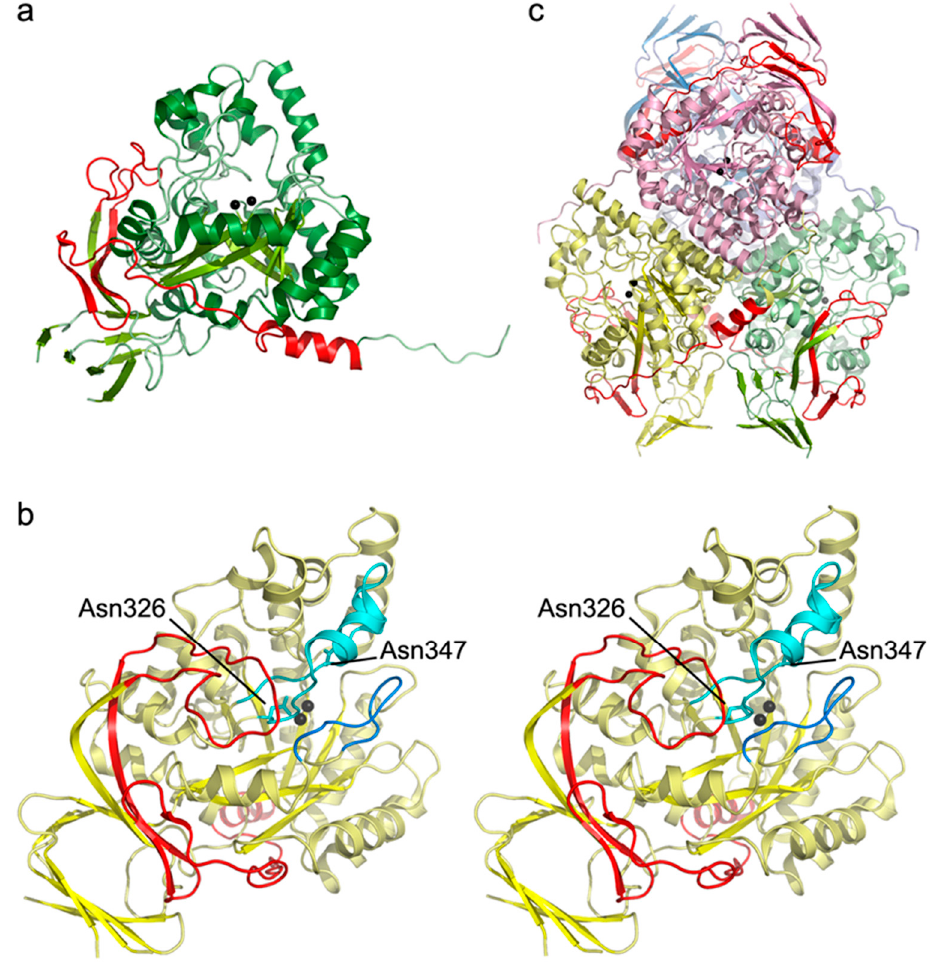
Figure 3. Location of the exon 8–encoded amino acids (in red) in the crystal structure of human dihydropyrimidinase (PDB-ID: 2VR2). ( a ) View of the dihydropyrimidinase subunit, with all but the exon 8–encoded amino acids shown in shades of green according to secondary structure. The zinc ions of the catalytic metal center are represented as black spheres; ( b ) Stereo view of the subunit from a different perspective compared to ( a ). The stereochemistry gate loop-1 (SGL-1) is depicted in blue, and the stretch of amino acids connecting the last barrel strand and barrel helix in cyan. Asp326 and Asn347 are labeled and shown as stick models in cyan; ( c ) The dihydropyrimidinase homotetramer, with the four subunits shown in green, yellow, pink and blue, respectively. The C-terminal helix (red) is wedged between the original and another subunit, while the following tail (not highlighted) is packed against the surface of a third subunit.